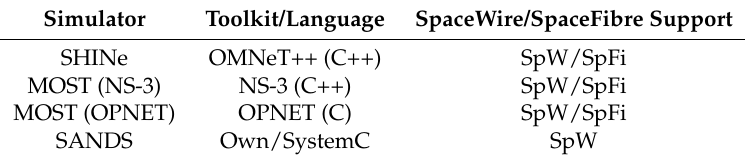
Table 1. Summary of the main SpaceWire/SpaceFibre network simulators